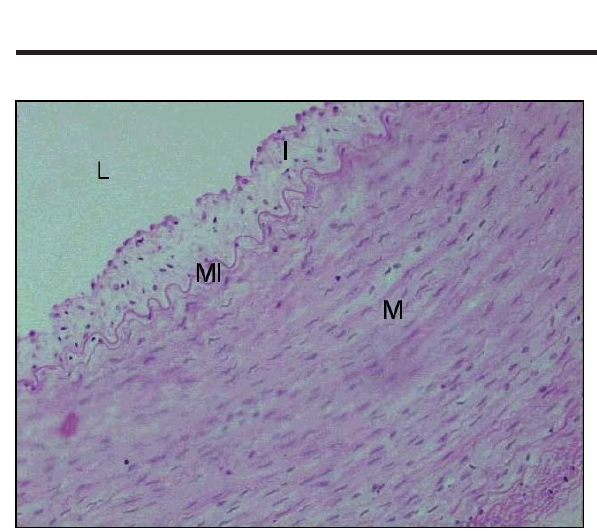
FIGURE 2 - Photomicrograph of RCC artery of NO STENT group 4 weeks after injury. Staining: HE.